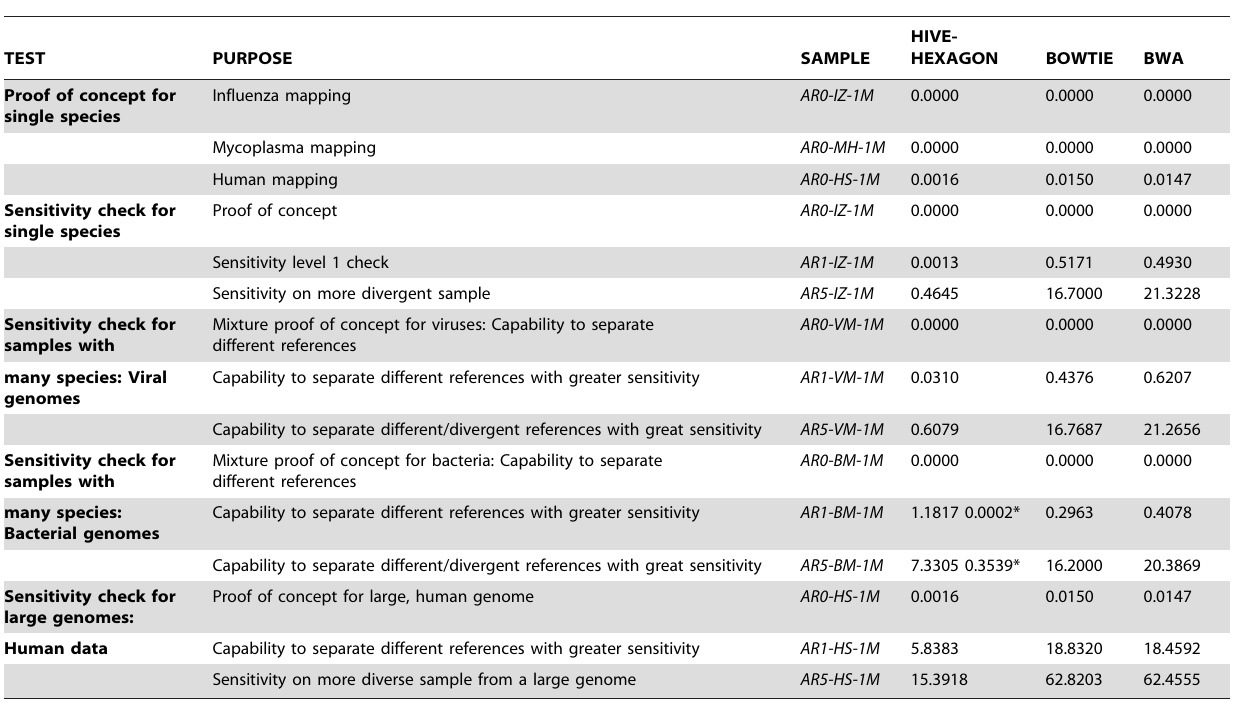
Table 1. Validity and Sensitivity Comparison of Alignment Tools in Native